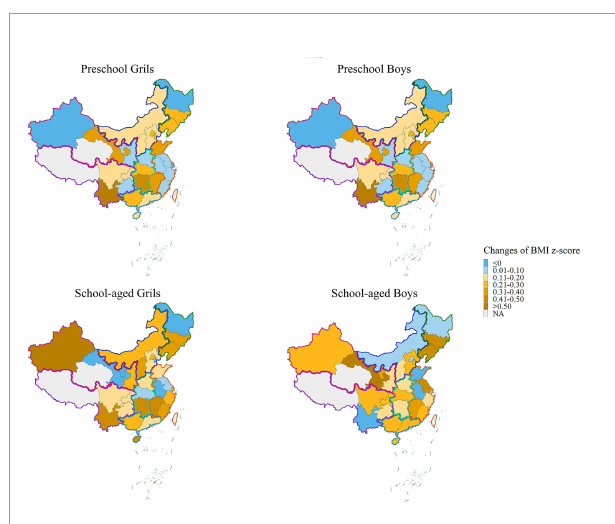
FIGURE 3 | BMI z-score changes during COVID-19 lockdown by province. The changes of the mean BMI z-score in the fi rst half of 2020 and that in